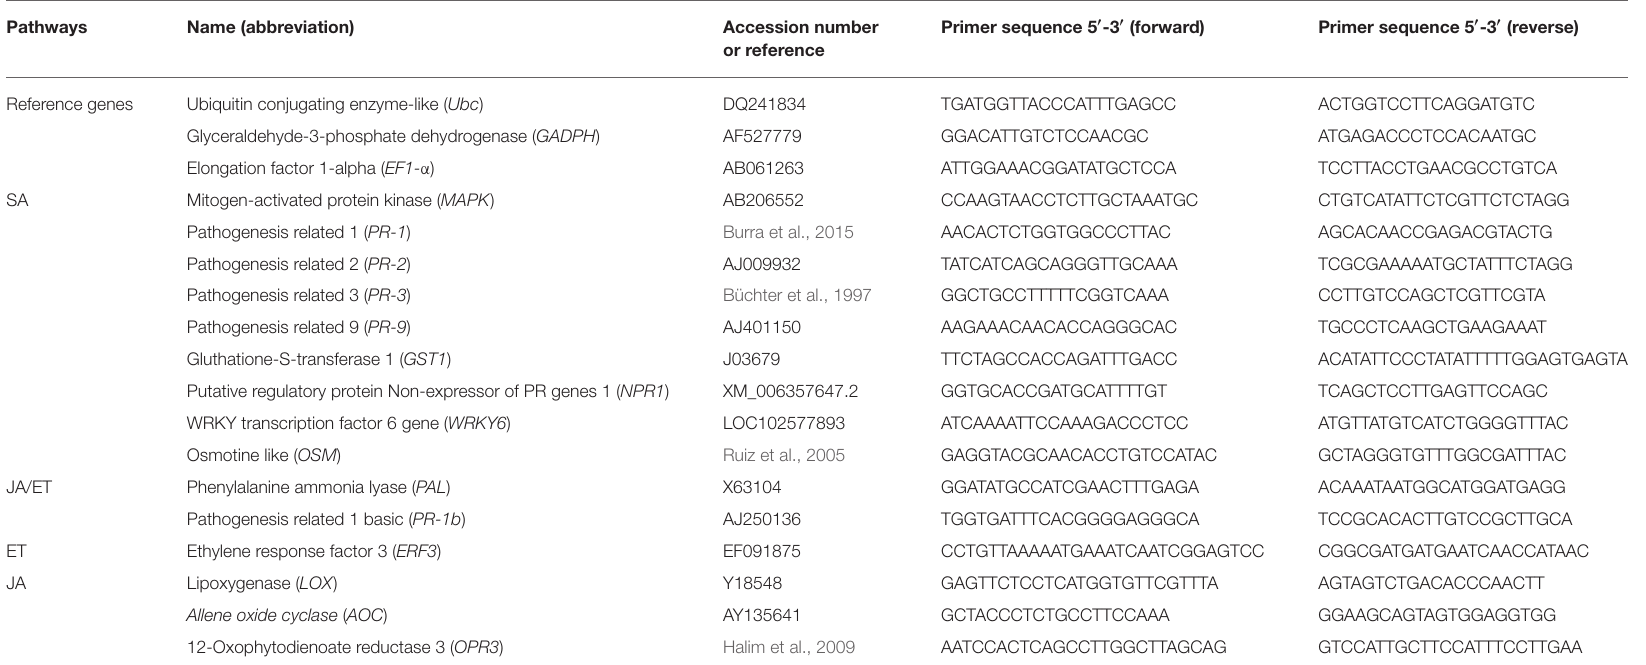
TABLE 1 | Primers used in the